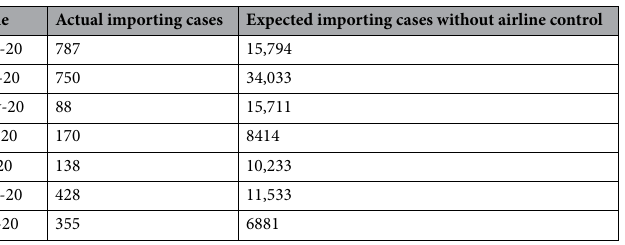
Table 2. Actual and expected importing cases in China from March to September 2020 (number of